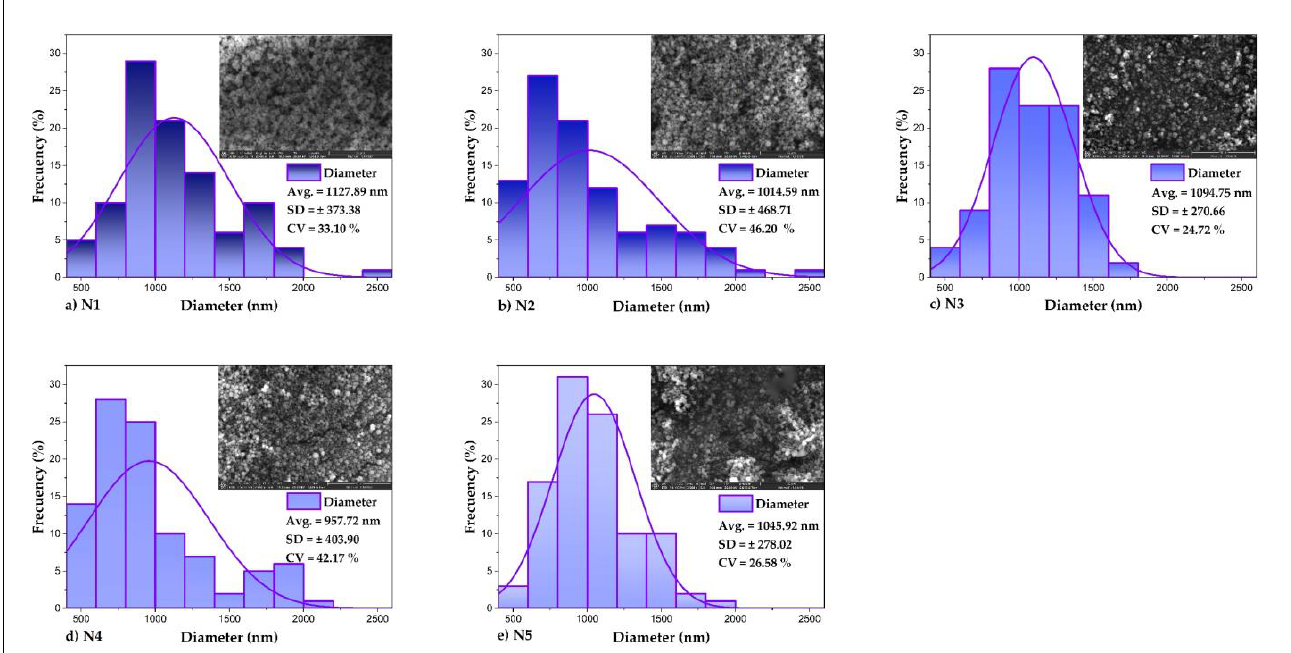
Figure 6. SEM images of nanoencapsulates ( a ) N1, ( b ) N2, ( c ) N3, ( d ) N4, and ( e ) N5, in ImageJ and Origin Pro.